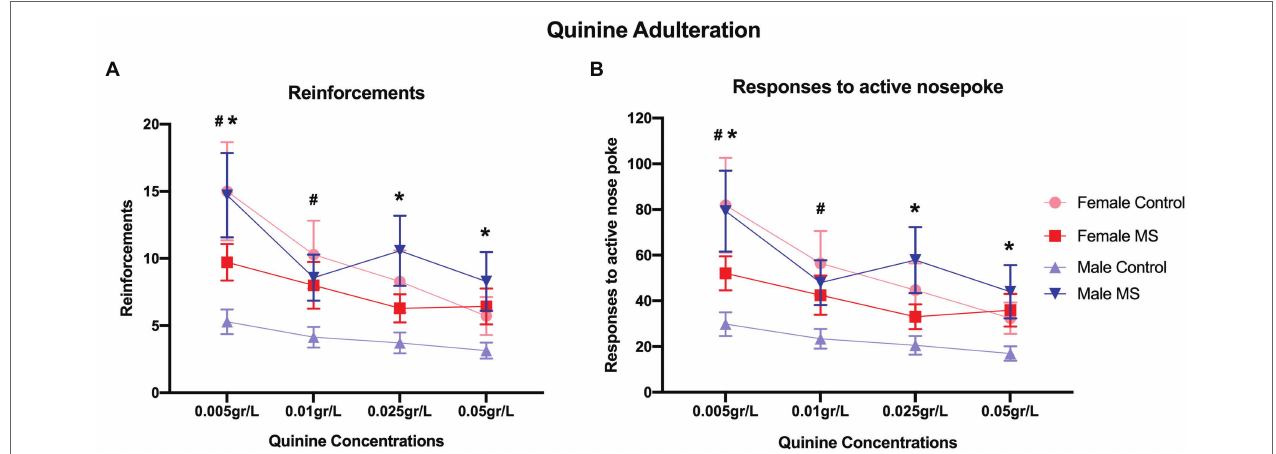
FIGURE 4 | Quinine adulteration protocol. Means of reinforcements (A) and mean of responses to active nose poke (B) of female and male mice submitted to MS and control group. N = 28 (Control: n = 14; female = 7, male = 7, MS: n = 14; female = 7, male = 7). LMM analysis, data: mean ± SEM. * p < 0.05 male MS group compared to male